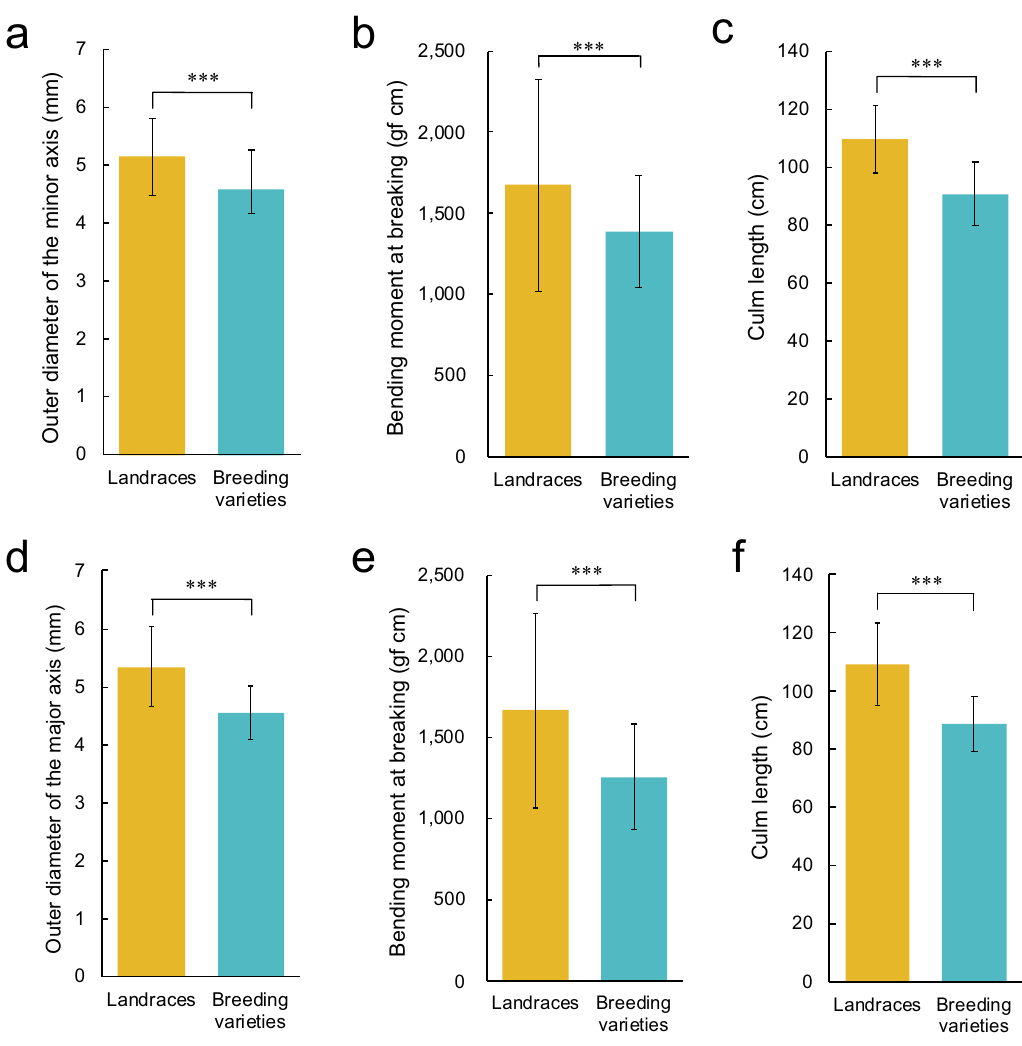
Figure 2. Trait values of landraces vs. breeding varieties. Bar graphs of mean (SD) phenotypic values: ( a) ODMI in 2018; ( b) BM in 2018; ( c) culm length in 2018; ( d) ODMI in 2019; ( e ) BM in 2019; ( f ) culm length in 2019. The yellow and blue bars indicate landraces and breeding varieties, respectively. *** indicates significant differences at P < 0.001 (two-tailed Welch’s t-test). Two-tailed Welch’s t-test was performed by R software (https:// www.R- proje ct. org/) 65